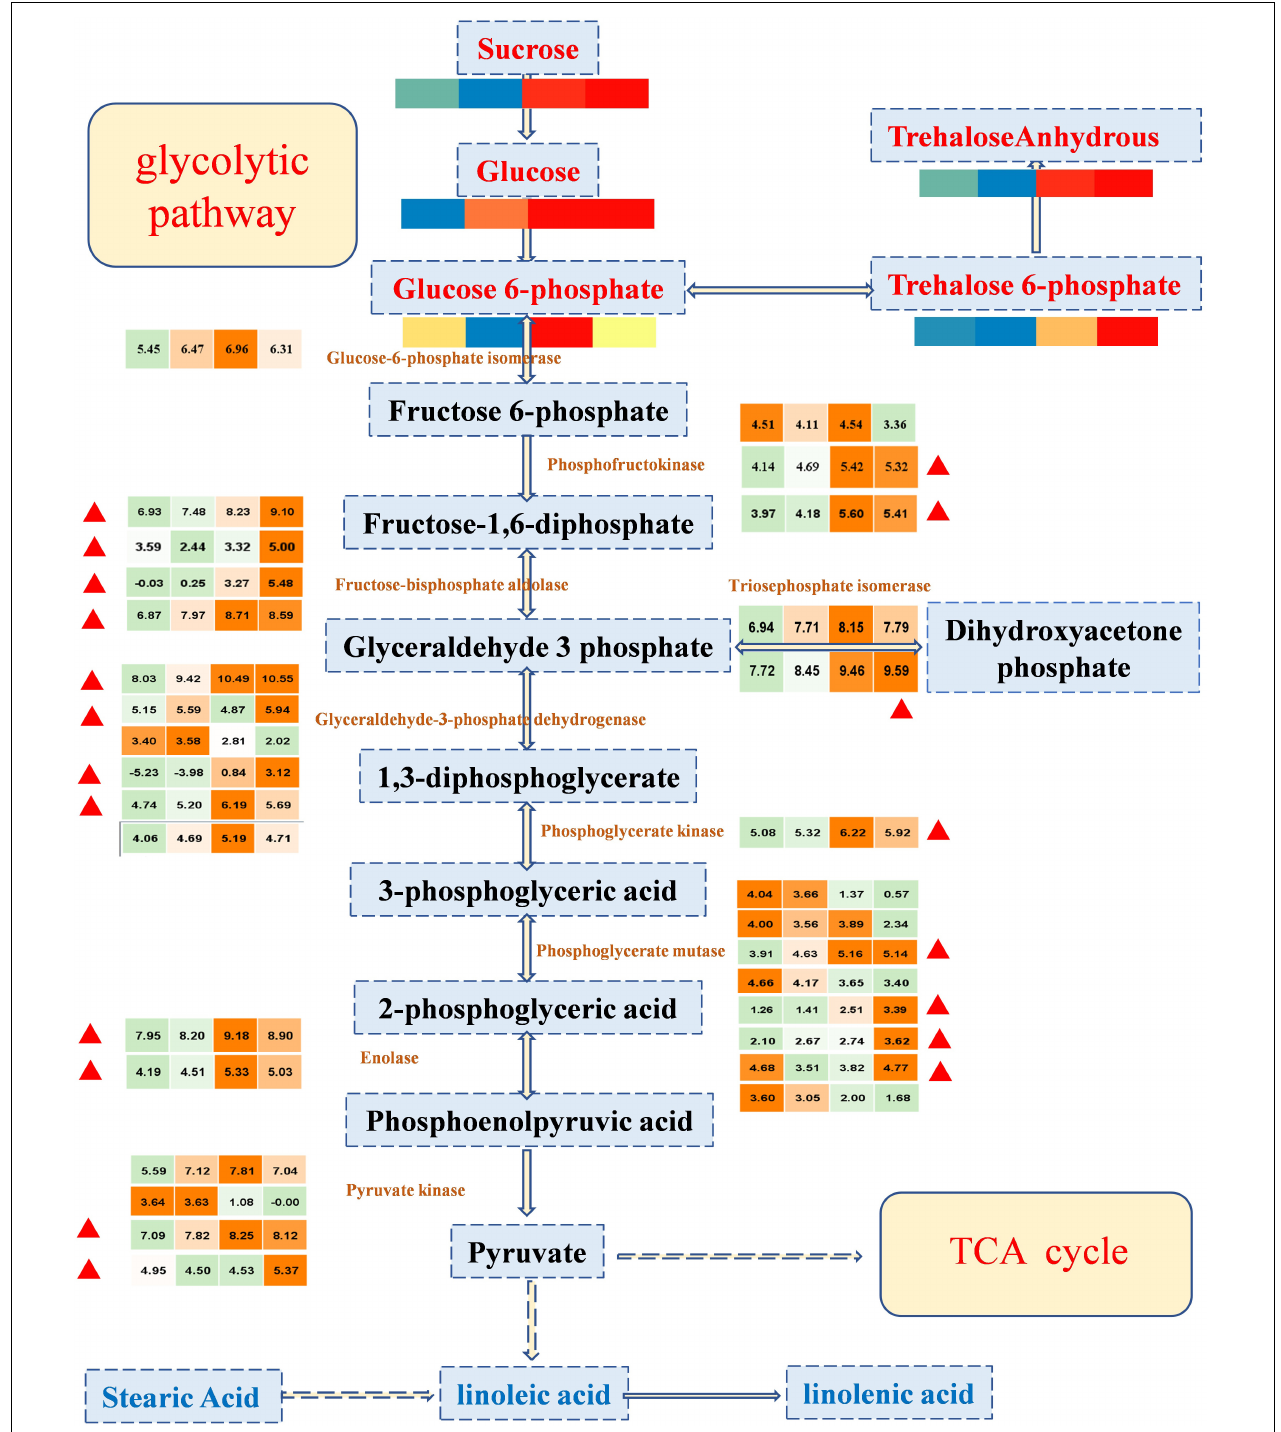
FIGURE 4 | The expression profile of important regulatory genes and the accumulation patterns of sugars in the glycolytic pathway during four important developmental periods. In the color scale, each cube metabolized the average of three replicates in the same period. The metabolite data were standardized by the logarithm of 10, and the gene was the logarithm of 2; red or orange represents a higher relative content, but blue or green represents a lower relative content, from left to right represents the average relative content of metabolites at 10, 18, 26, and 34 DAP, respectively. The red triangle represents that the enriched genes in class 4 and class 5 are in the K-means clustering analysis, showing a tendency of